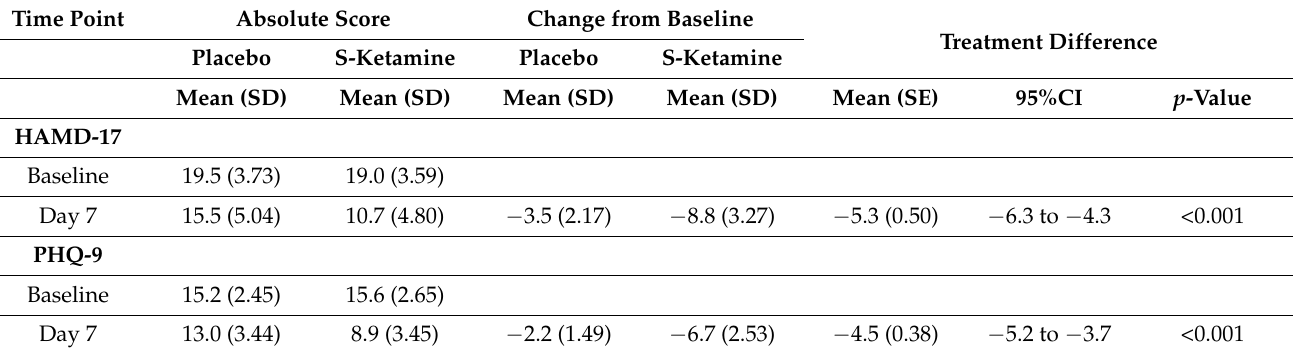
Figure 2. Trends in depressive scores after surgery. ( a ) HAMD-17 scores of enrolled patients; ( b ) PHQ-9 scores of enrolled patients. The line plot exhibits the mean scores for each group, and the error bars represent the SD for timepoints. The HAMD-17 and PHQ-9 scores of the S-ketamine group were significantly lower than those of the placebo group on the 1st, 3rd, and 7th day post operation (Bonferroni’s adjusted p < 0.001). ( c ) QoR-15 scores at 1 day, 3 days, 7 days, and 30 days after operation; the QoR-15 scores at 3 days and 7 days after operation in the S-ketamine group were significantly higher than those of the placebo group (Bonferroni’s adjusted p < 0.001). ( d ) NRS scores at PACU 1 day, 2 days, and 7 days after operation; the NRS scores of PACU 1 day and 2 days after operation in the S-ketamine group decreased significantly (Bonferroni’s adjusted p < 0.001). The symbol * represents p < 0.001. HAMD-17, seventeen-item Hamilton depression scale; SD, standard deviation; PHQ-9, nine-item patient health questionnaire. QoR-15, quality of recovery form. NRS, numeric rating scale; PACU, post-anesthesia care unit. Table 2. HAMD-17 and PHQ-9 total score and change from baseline score at day